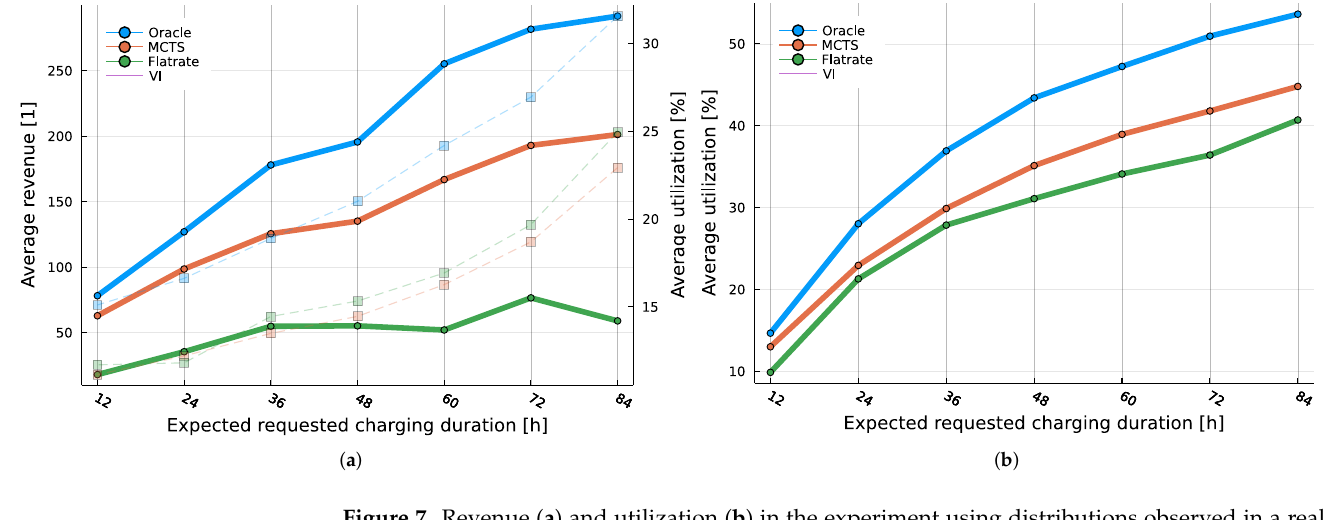
Figure 7. Revenue ( a ) and utilization ( b ) in the experiment using distributions observed in a real charging location. The right-hand y-axis and thin plot lines in ( b ) show the utilization of each method (that was not the optimization criterion). Here, the number of timeslots is fixed at 48, meaning 30 min charging timeslots, while the expected demand increases from 1/6th of the available charging capacity (3 chargers with 48 charging timeslots each) to